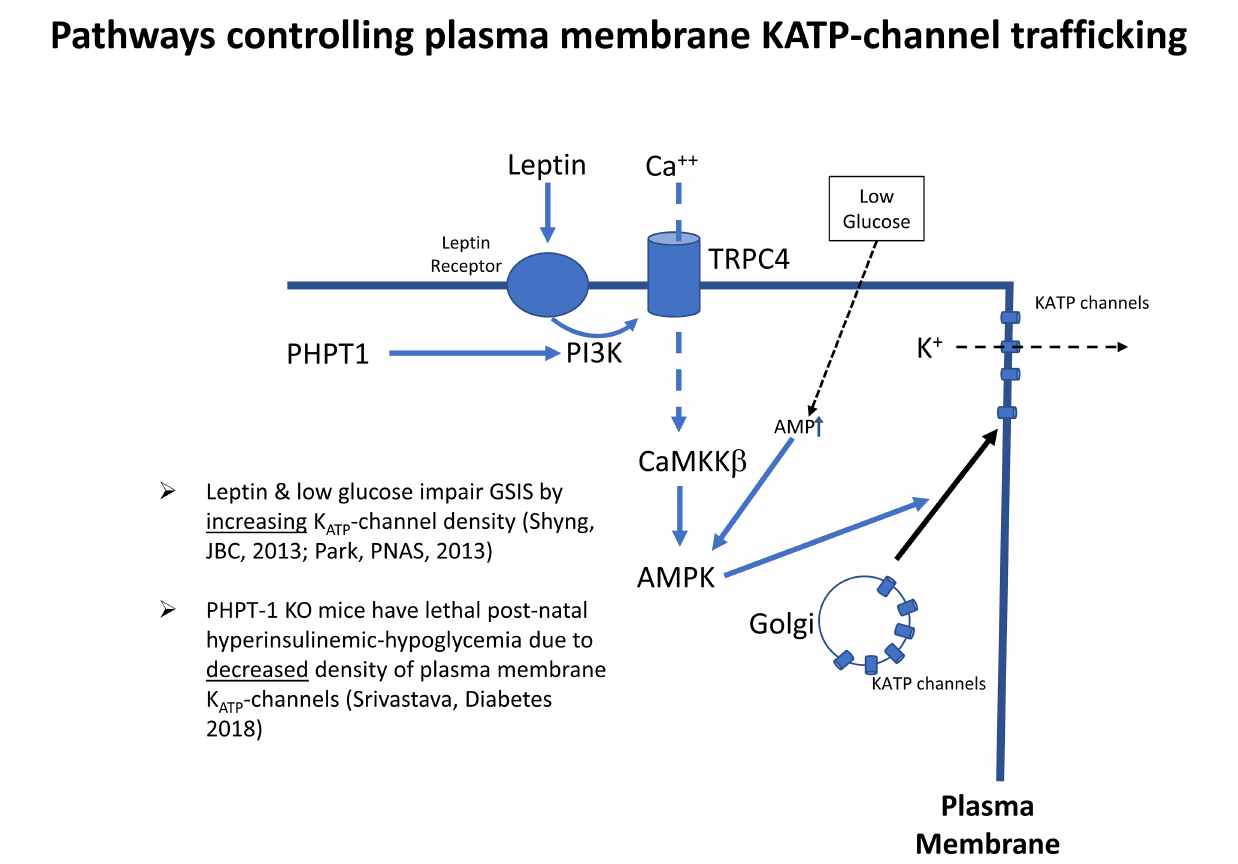
FIGURE 6 Signals controlling K ATP -channel traf fi cking from Golgi to plasma membrane. K ATP channels traf fi c to the plasma membrane in response to activation of AMP-kinase by the calcium/calmodulin protein kinase 2, (CaMKKß). Abbreviations: PHPT1, protein histidine phosphatase 1; PI3K, phosphatidyl-inositol 3 kinase; TRPC4, transient receptor potential cation channel subfamily C member 4; AMPK, AMP-activated protein kinase; KATP, ATP-sensitive potassium